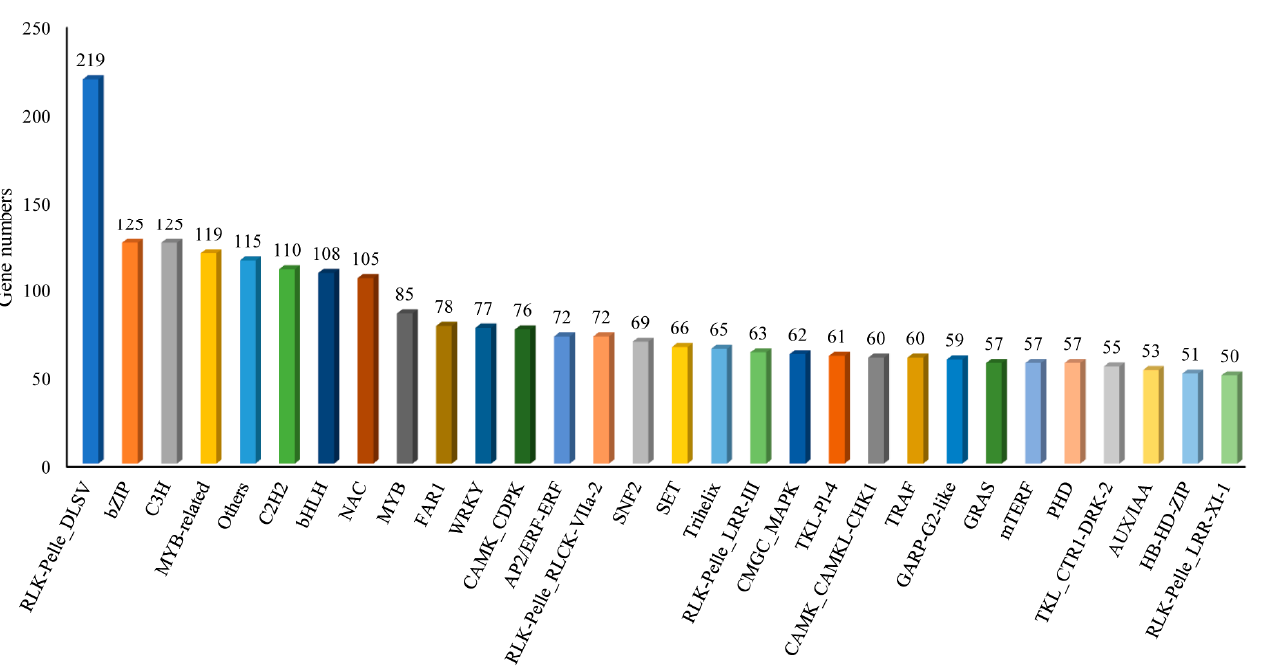
Figure 5. Numbers and families of the top 30 TFs in N. sibirica under salt stress.